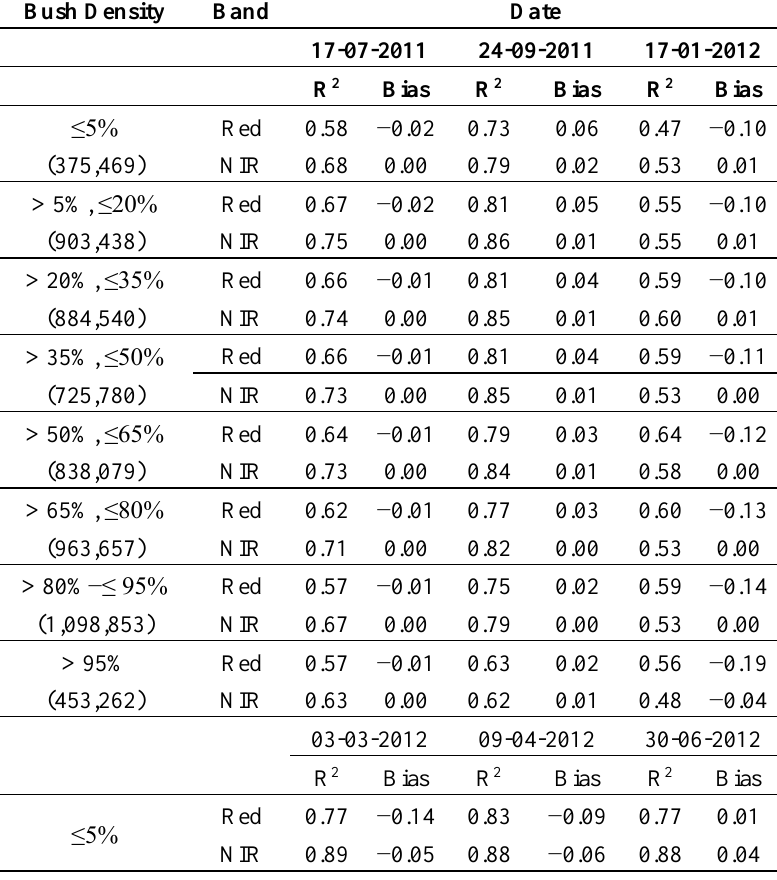
Table 4. Pixel based regression of the observed RapidEye scenes against the correspondent ESTARFM predicted images for Subset 2, summarized for bush cover classes. See Table 3 for further